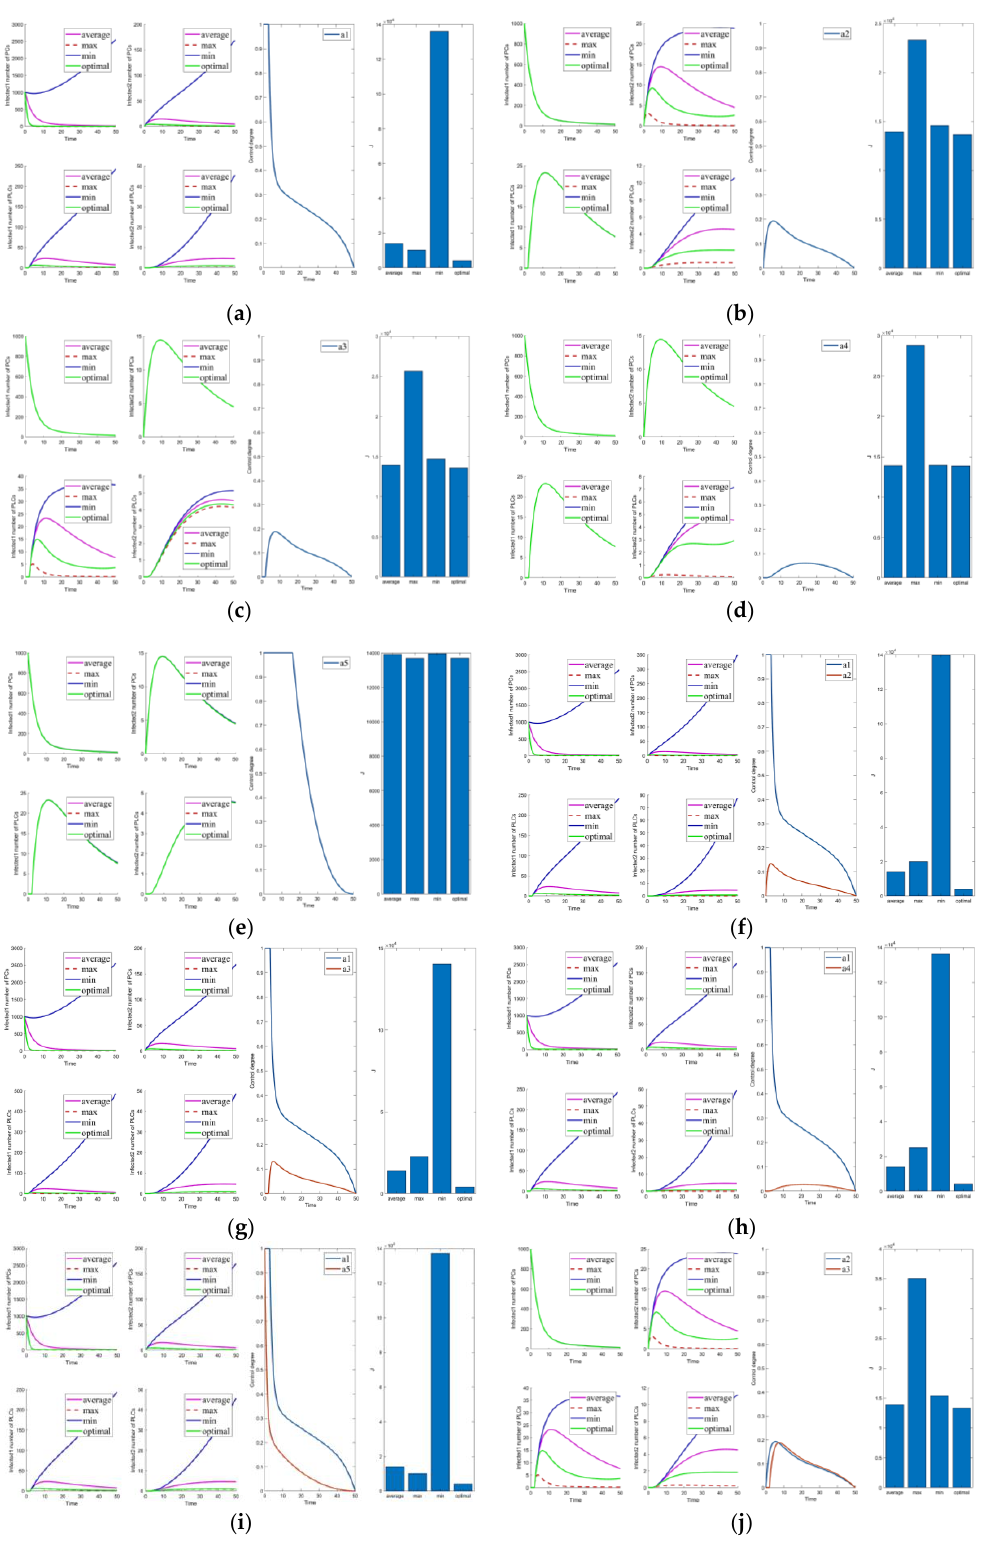
Figure 3. Solutions of the optimal control strategies for Cases 1 – 10. ( a ) Case 1; ( b ) Case 2; ( c ) Case 3; ( d ) Case 4; ( e ) Case 5; ( f ) Case 6; ( g ) Case 7; ( h ) Case 8; ( i ) Case 9; ( j ) Case 10.